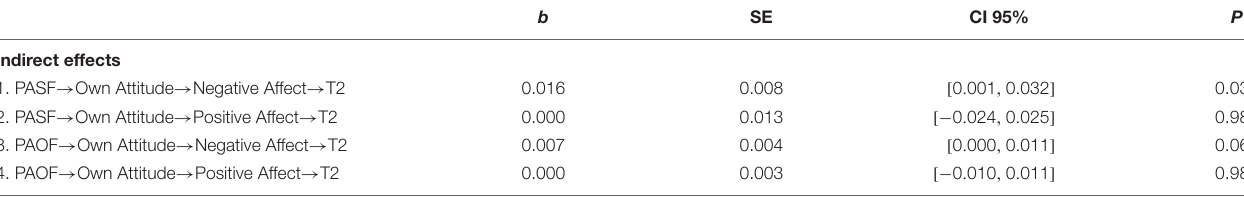
TABLE 4 | Pathways from perceived hookup attitude of gender-specific close friends to hookup partners ( N = 314). b SE CI 95%